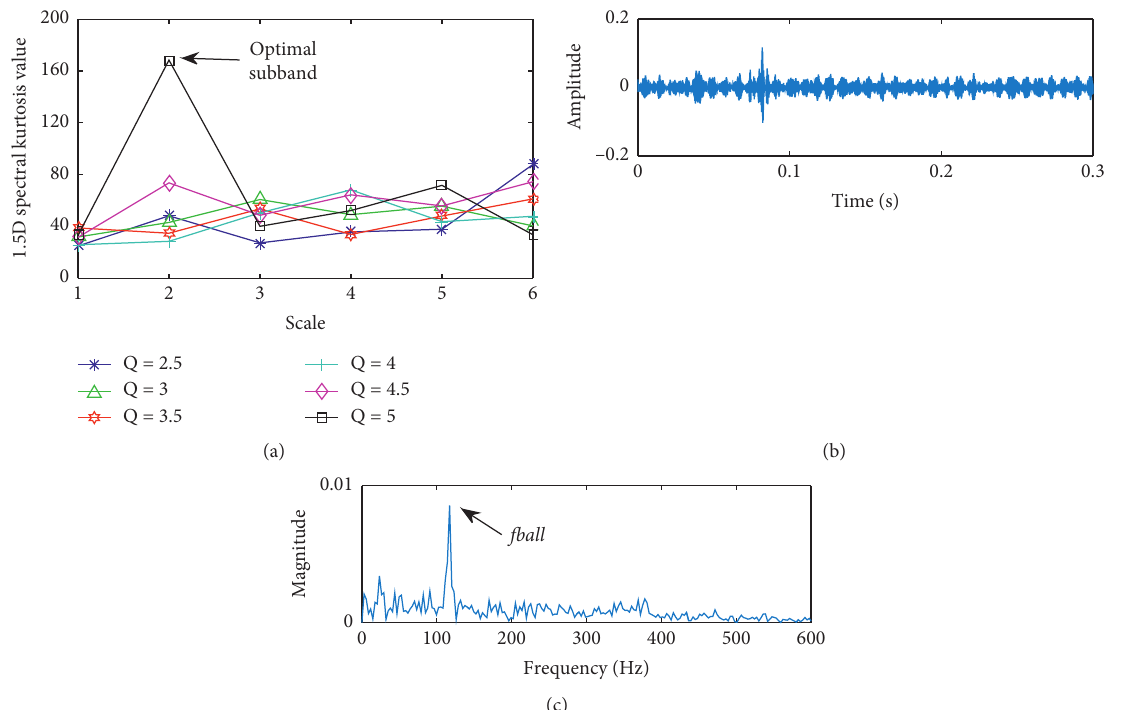
Figure 11: (a) Optimal subband selection process of the 1.5D spectral kurtosis-guided TQWT method, (b) time-domain waveform of the optimal subband, and (c) 1.5D spectrum of (b).